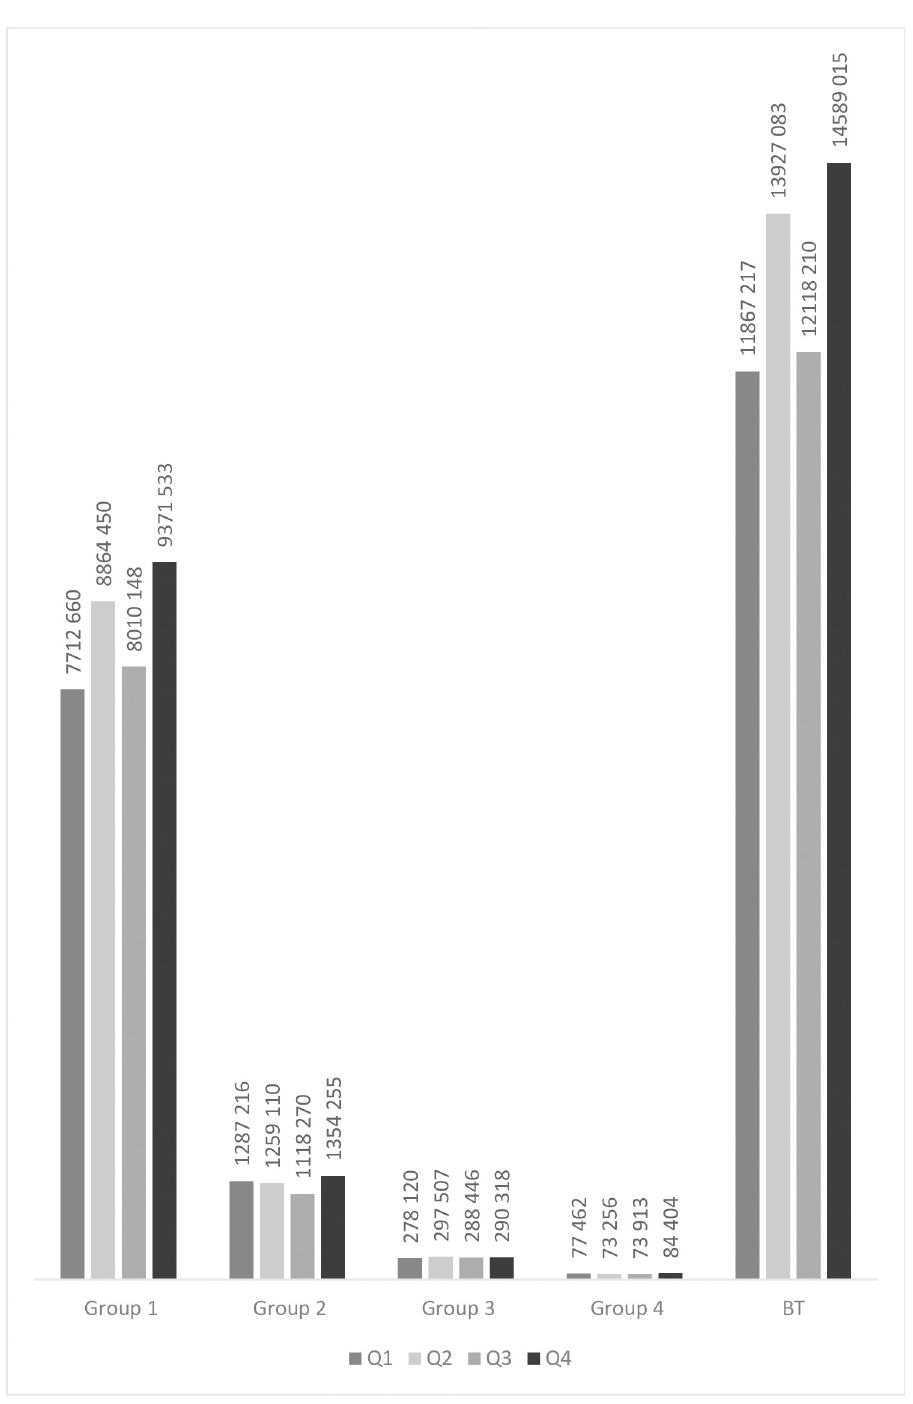
Fig 4. The association between a player’s quarter of birth and market